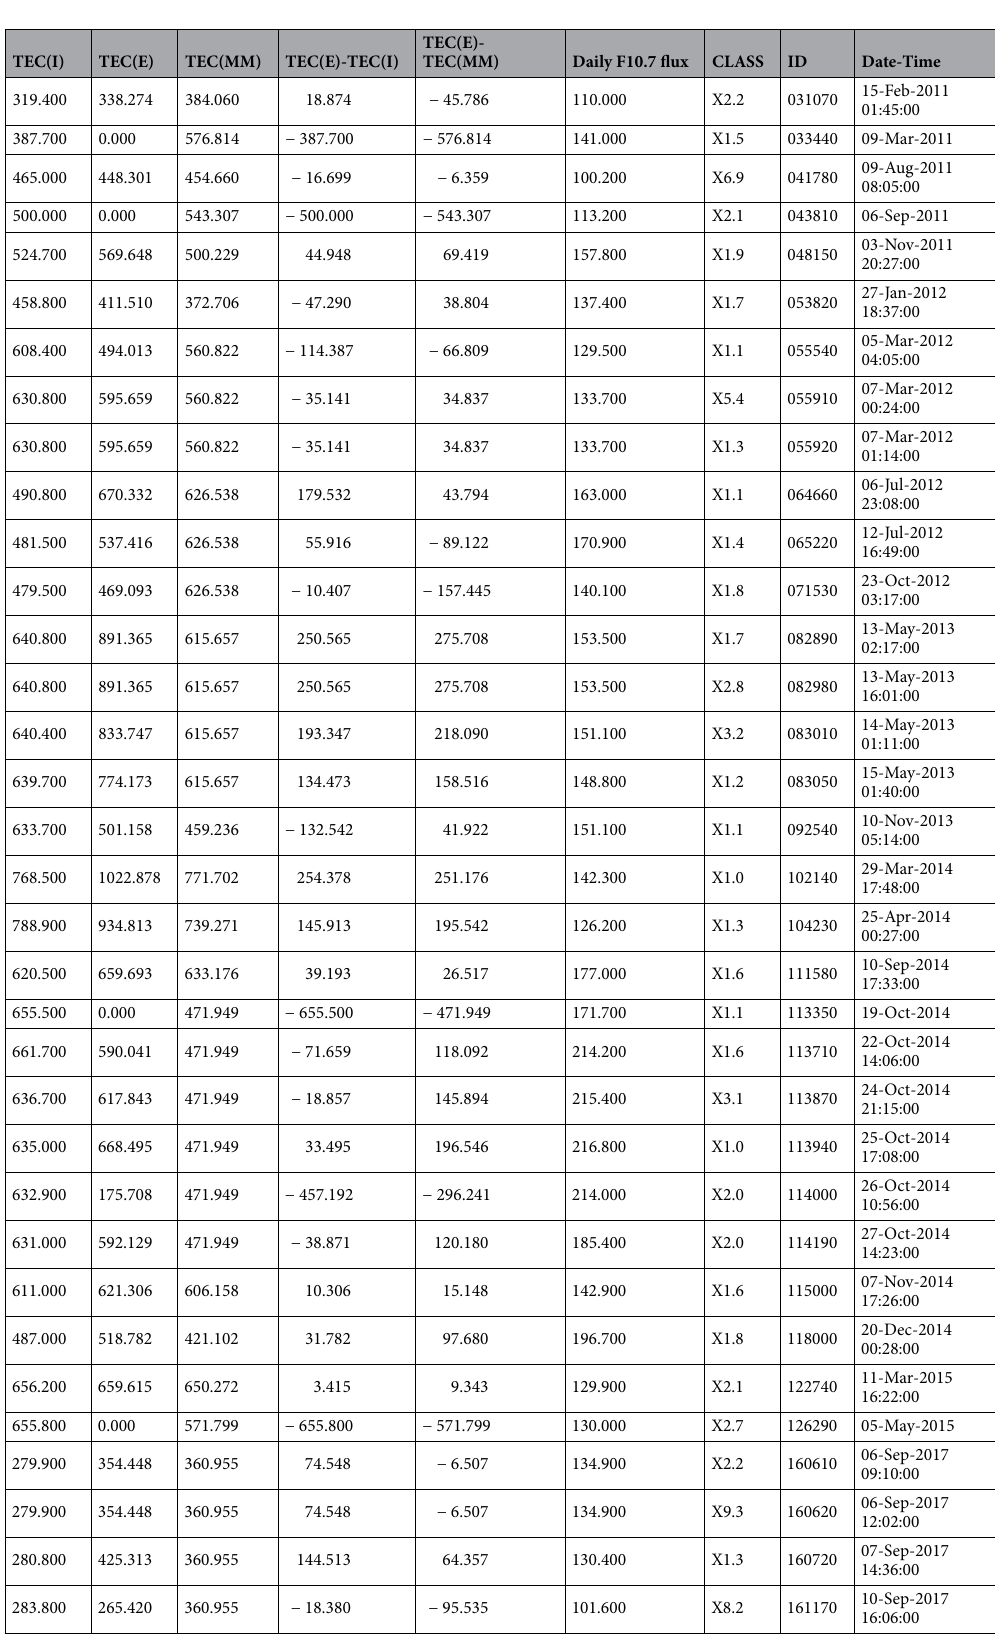
Table 2. Our results compared with the results of IRI model (2016) for solar event of tabel 1. TEC(E), TEC(MM) and TEC(I) represent experimental, calculated by this model and calculated by IRI model values of